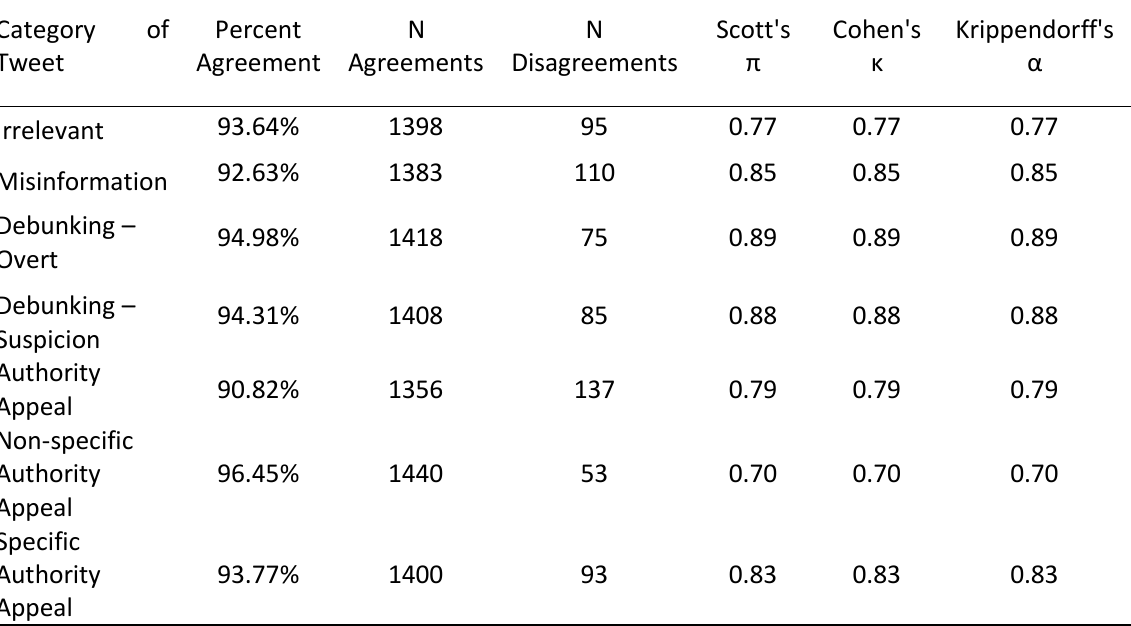
Table 4 . Intercoder reliability statistics for the coded tweets (N =